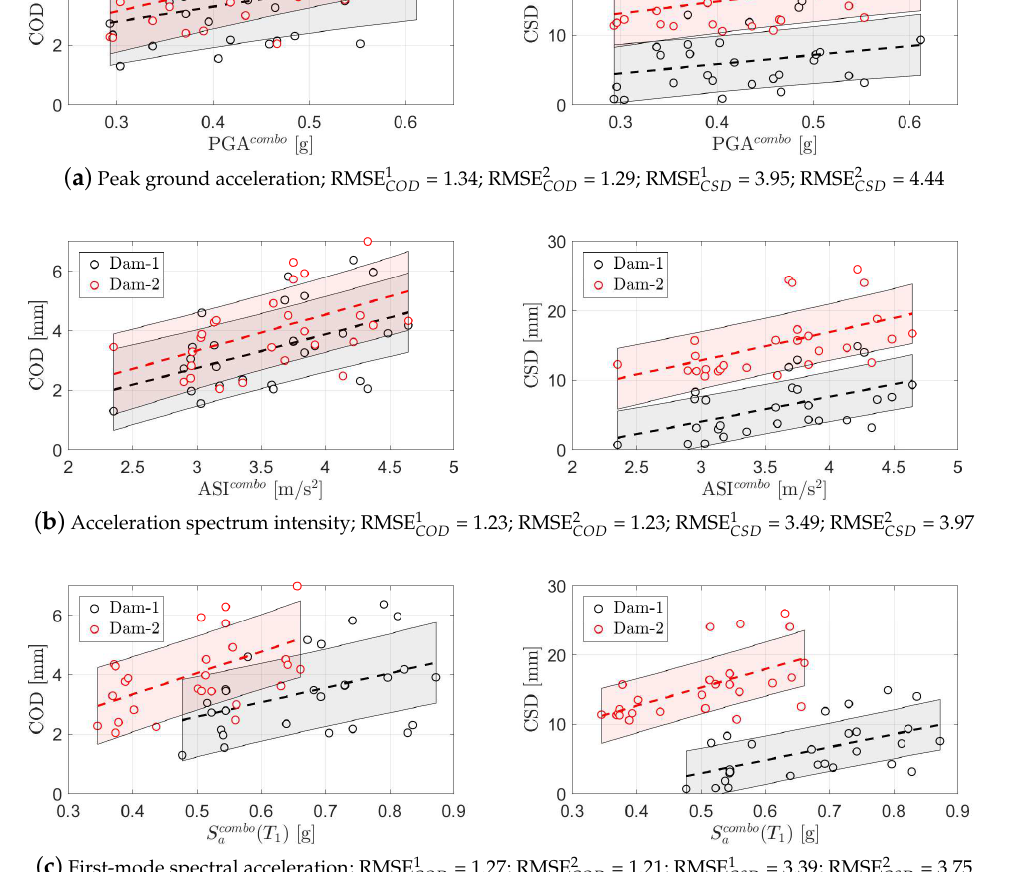
Figure 10. ( a – c ) Correlation between the joint opening and sliding with seismic intensity